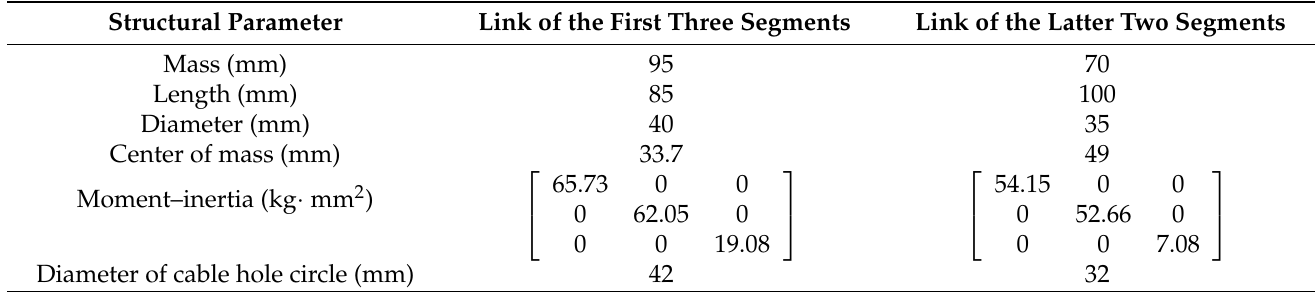
Table 2. Structure parameters of the